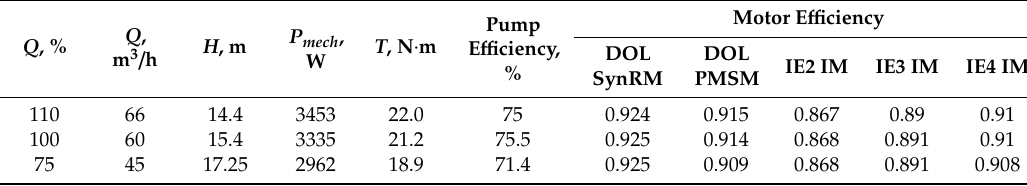
Table 4. Characteristics of the pump duty cycle.